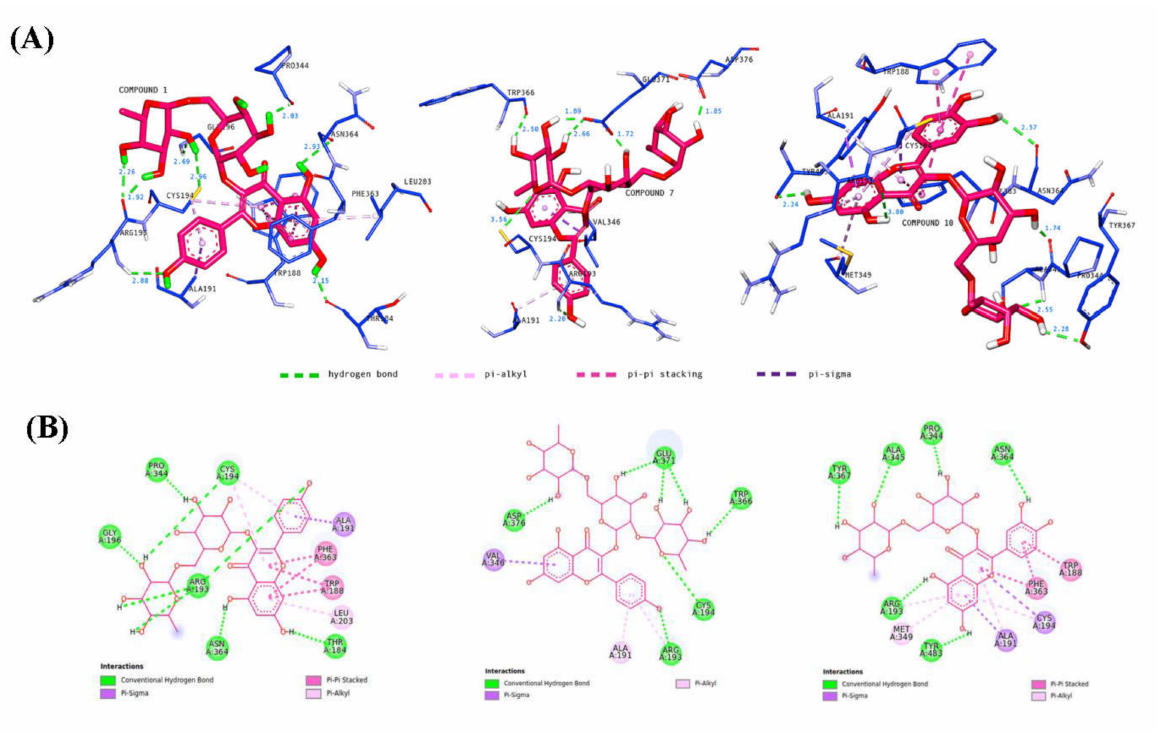
Figure 15. Binding interactions of major active metabolites 1 , 7 , and 10 against the iNOS enzyme with ( A ) 3D and ( B ) 2D representations. Each hydrogen distance (Å) is labeled in blue color near its respective hydrogen bond. For clarity, only ligands and interacting residues are